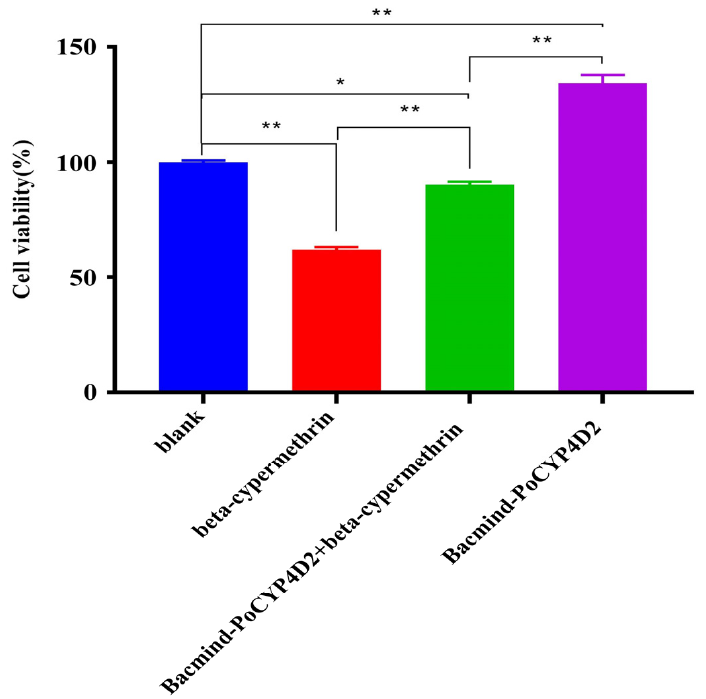
Figure 4. Effects of bacmind transfection on the inhibition of S2 cells by the β -cypermethrin treatment (X ± s, n = 3) Note: Different colors means different groups, * p < 0.05, ** p < 0.01.